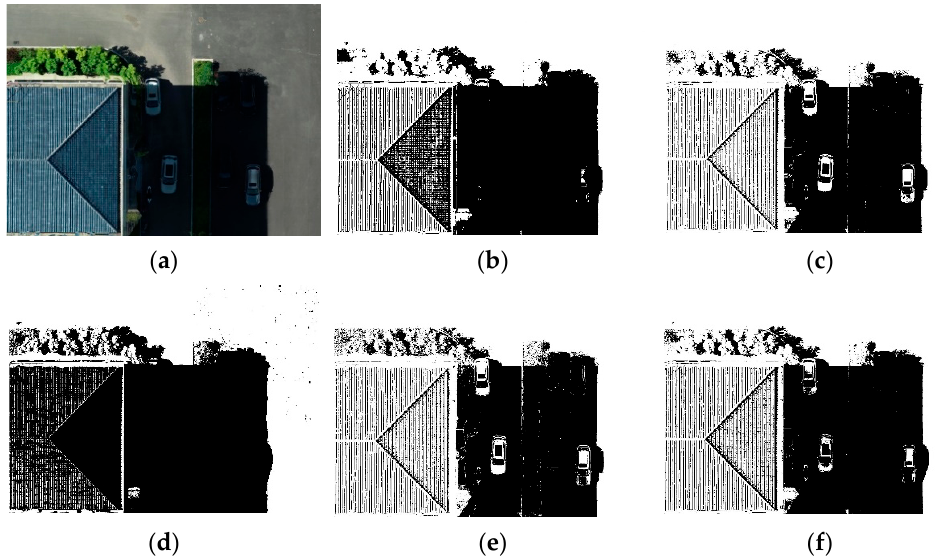
Figure 5. The detection results of different methods applied to study case 1: ( a ) original image shown with R, G, B bands; ( b ) SDI; ( c ) T YCbCr ; ( d ) T HSV ; ( e ) NSVDI; ( f ) SI.